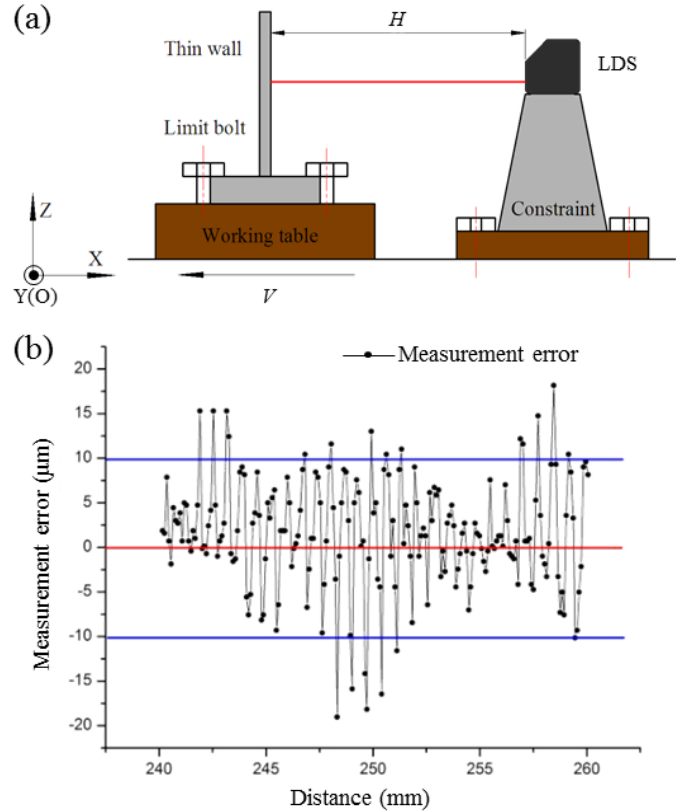
Figure 2. Measurement accuracy calibration: ( a ) schematic of the calibration method, ( b ) the error distribution with working table stepping per 100 µ